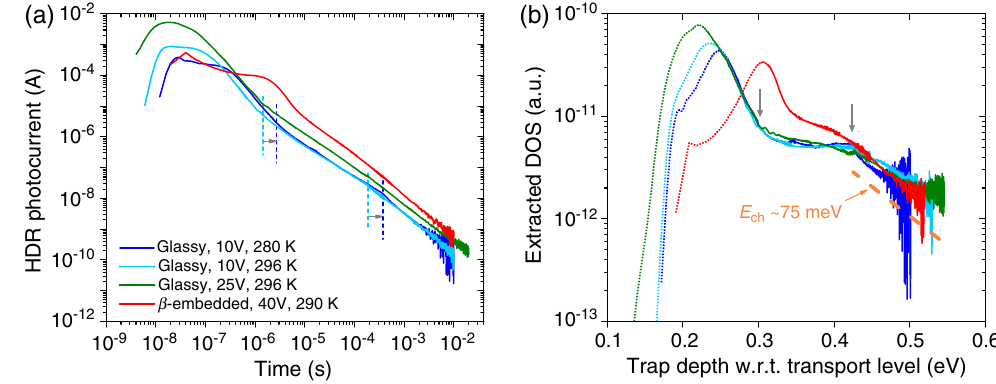
FIG. 5. (a) HDR TOF transients for a glassy HMW PFO device measured at different voltages and temperatures, in comparison with a transient for a β -phase embedded HMW PFO device acquired at a high bias. (b) Density of states extracted from the HDR transients